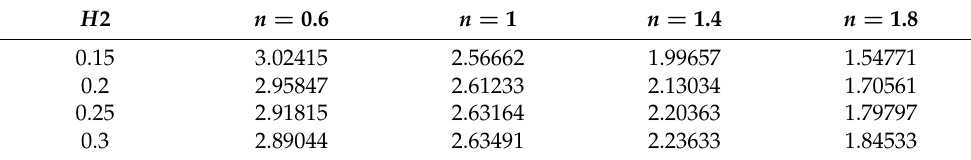
Table 12. The values of the average Nusselt number ( Nu avg ) at the heated boundary.